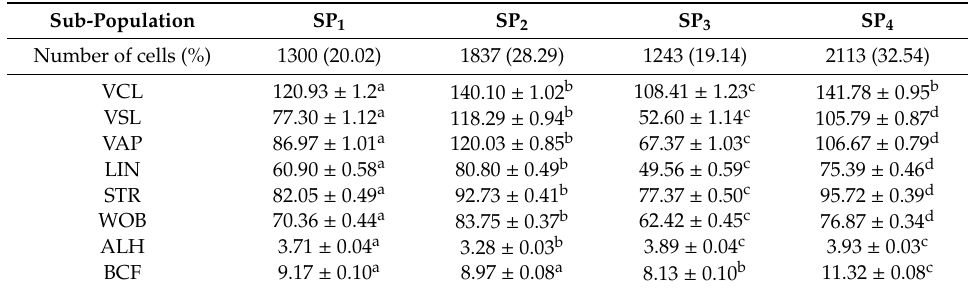
Table 1. Kinematic variables (mean ± SEM) of the four sperm sub-populations (SPs) defined at 60 min post-thawing bull semen samples.